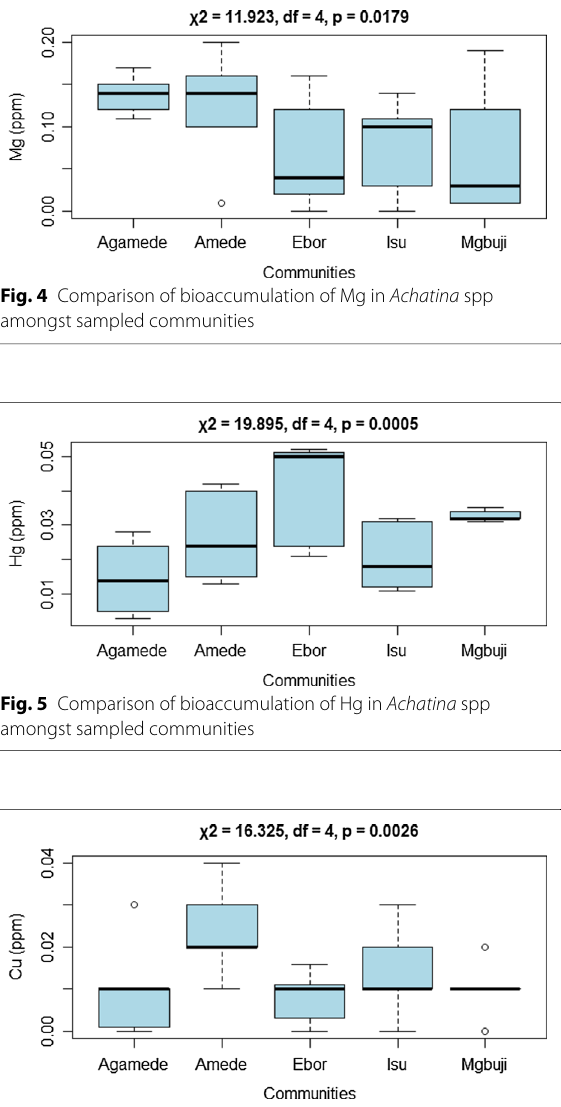
Fig. 6 Comparison of bioaccumulation of Cu in Achatina spp amongst sampled communities